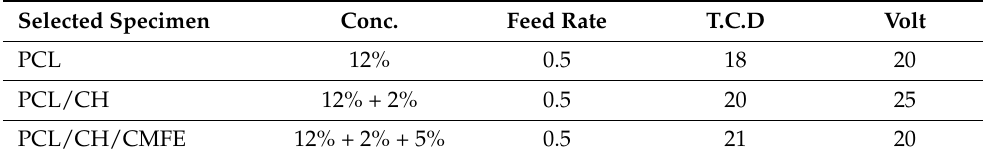
Table 1. The electrospinning settings of fabricated fibrous mats. Selected Specimen